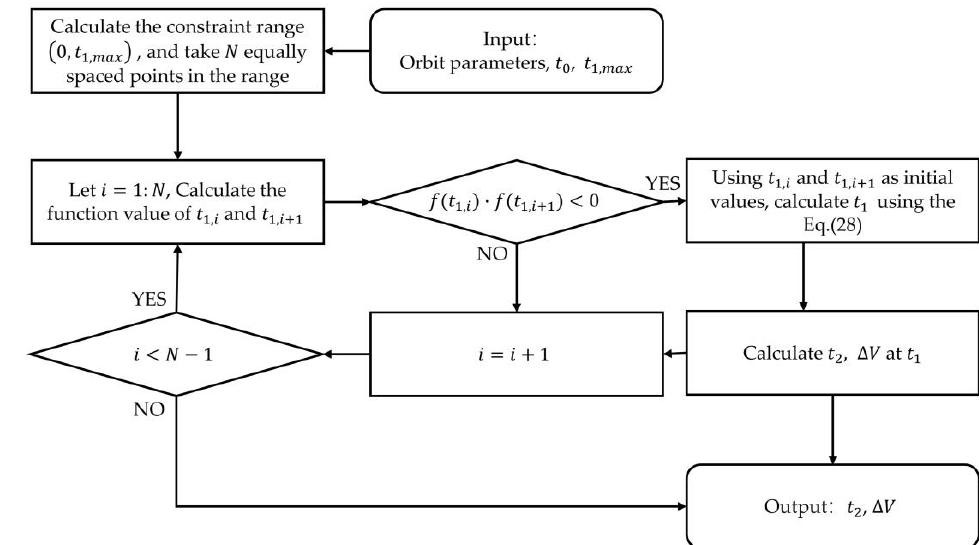
Figure 5. Flowchart the problem’s solution.